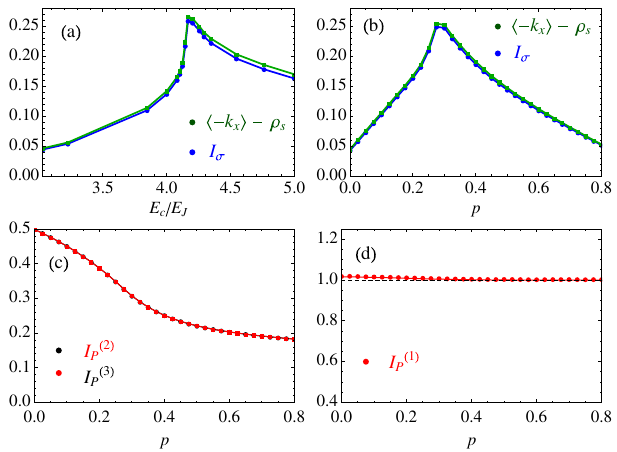
FIG. 8. Sum rules for quantities calculated using maximum entropy analytic continuation. (a),(b) The conductivity sum rule [Eq. (B5)] for the clean ( p ¼ 0 ) and disorder-tuned ( E c =E J ) transitions. (c),(d) The sum rules given by Eqs. (B8) and (B9) for the boson spectral function P ð ω Þ for the disorder-tuned tran- sition. In all cases, the results shown are for T=E J ¼ 0 . 156 but hold at all temperatures considered in this